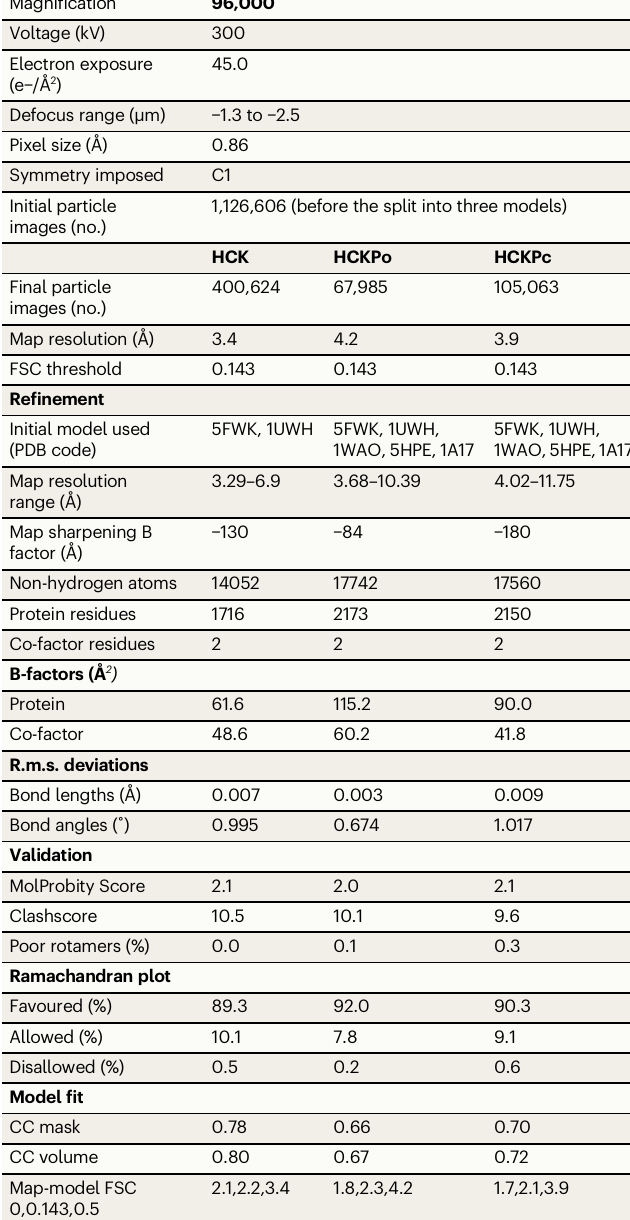
Table 1 | CryoEM data collection and model re fi nement parameters for HSP90 – CDC37 – BRAFV600E (HCK), HSP90 – CDC37 – BRAFV600E – PP5 open (HCKPo) and HSP90 – CDC37 – BRAFV600E – PP5 closed